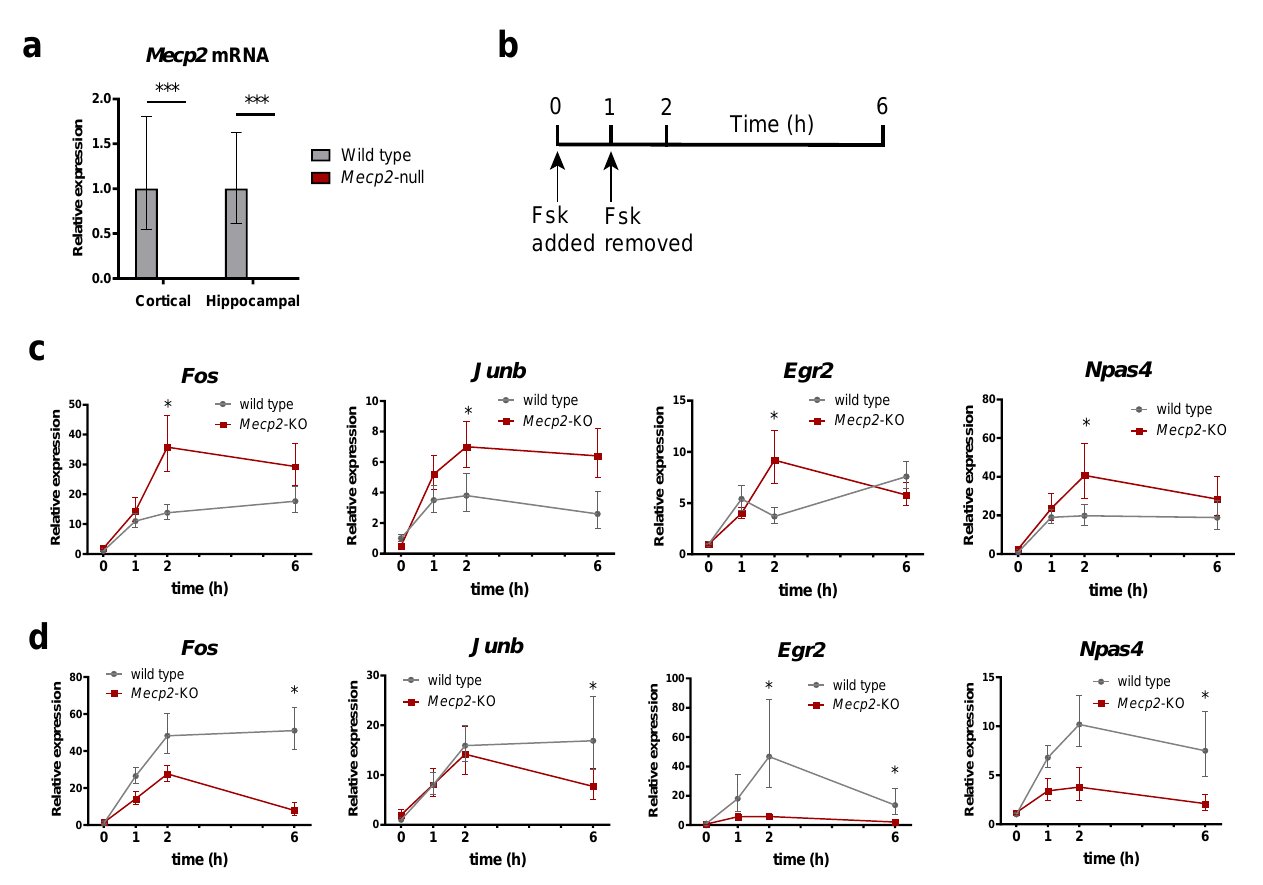
Figure 3. IEGs gene expression response to Forskolin is dysregulated in 8-weeks Mecp2 -KO mice neurons. ( a ) Mecp2 expression in cortical and hippocampal neurons, as measured by RT-qPCR. ( b ) Schematics indicating treatment of cultured primary neurons with forskolin and time-course of sample collection. ( c , d ) Time-course of Fos , Junb , Egr2 and Npas4 transcript levels analysis for both WT and Mecp2 -KO hippocampal ( c ) or cortical ( d ) neurons upon treatment with forskolin. All expression data are relative to WT unstimulated values ( n = 3 biological replicates for each condition, means ± SEM are represented, * p < 0.05 and *** p < 0.001 in Student’s t -tests).